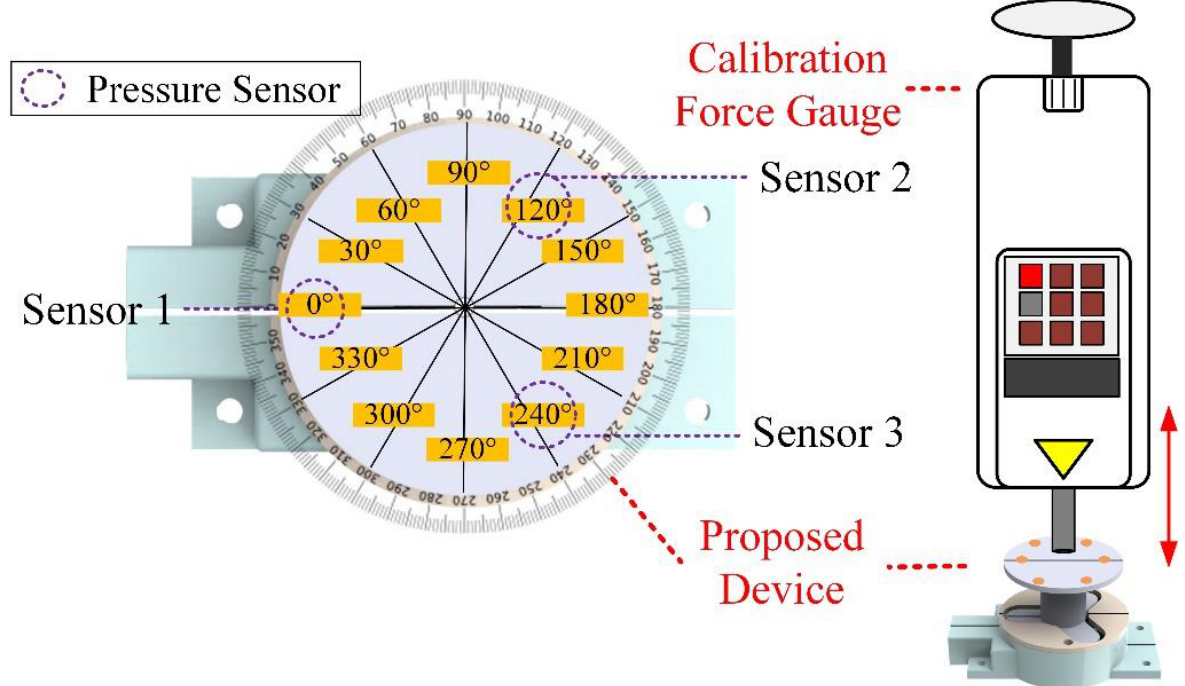
Figure 6. Schematic diagram of the multi-point diaphragm force-sensing correlation test. The experimental data presented in Table 1 show that different forces correspond to different A/D values, and the output force could be calculated by the regression curve equation. Figure 7 shows the results of the linear regressive analysis between the A/D values and testing force ( R 2 = 0.99), and Table 1 shows the errors of the output force that were calculated by the regression curve equation and the average error was below